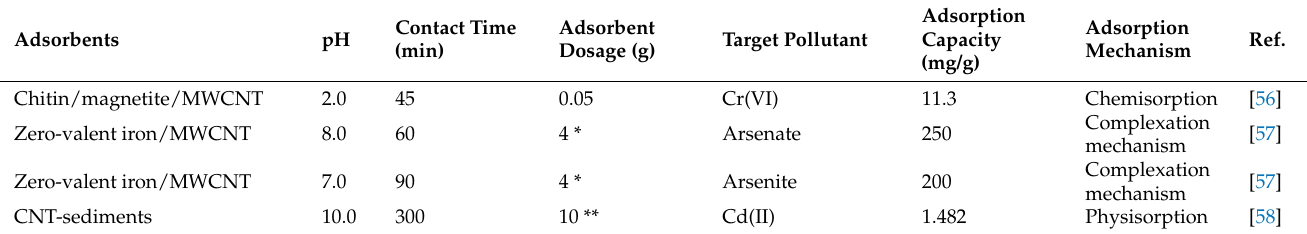
Table 2. Reported studies on CNTs’ application for the removal of wastewater